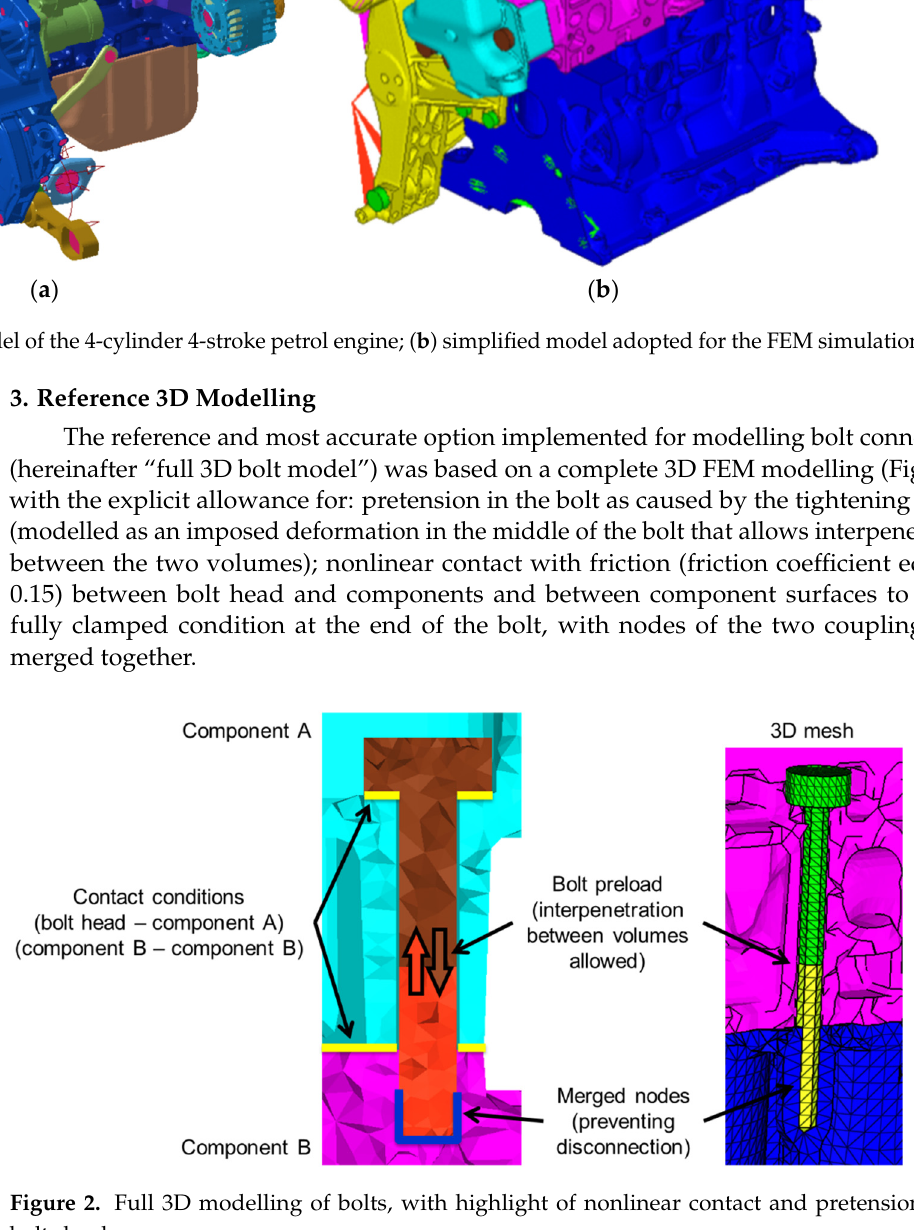
Figure 1. ( a ) Full CAD model of the 4-cylinder 4-stroke petrol engine; ( b ) simplified model adopted for the FEM simula- tions.